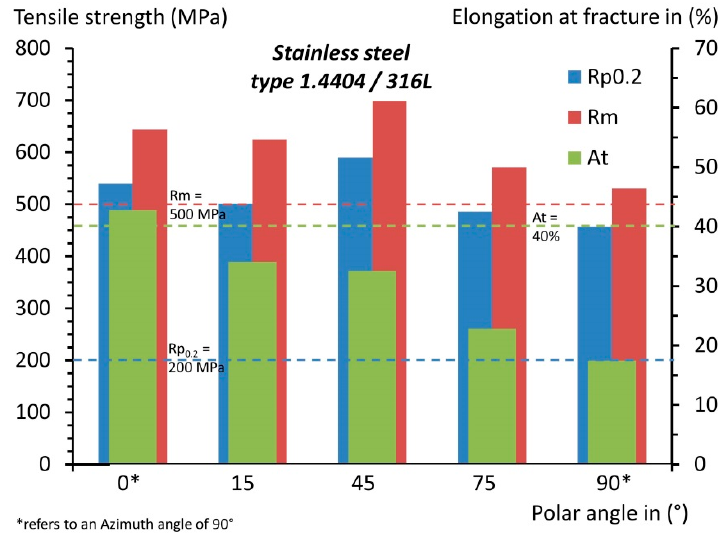
Figure 9. Comparison of additively manufactured and bulk base 1.4404 [67]. Table 7. Ratio between the yield point and the ultimate tensile strength for 1.4404.